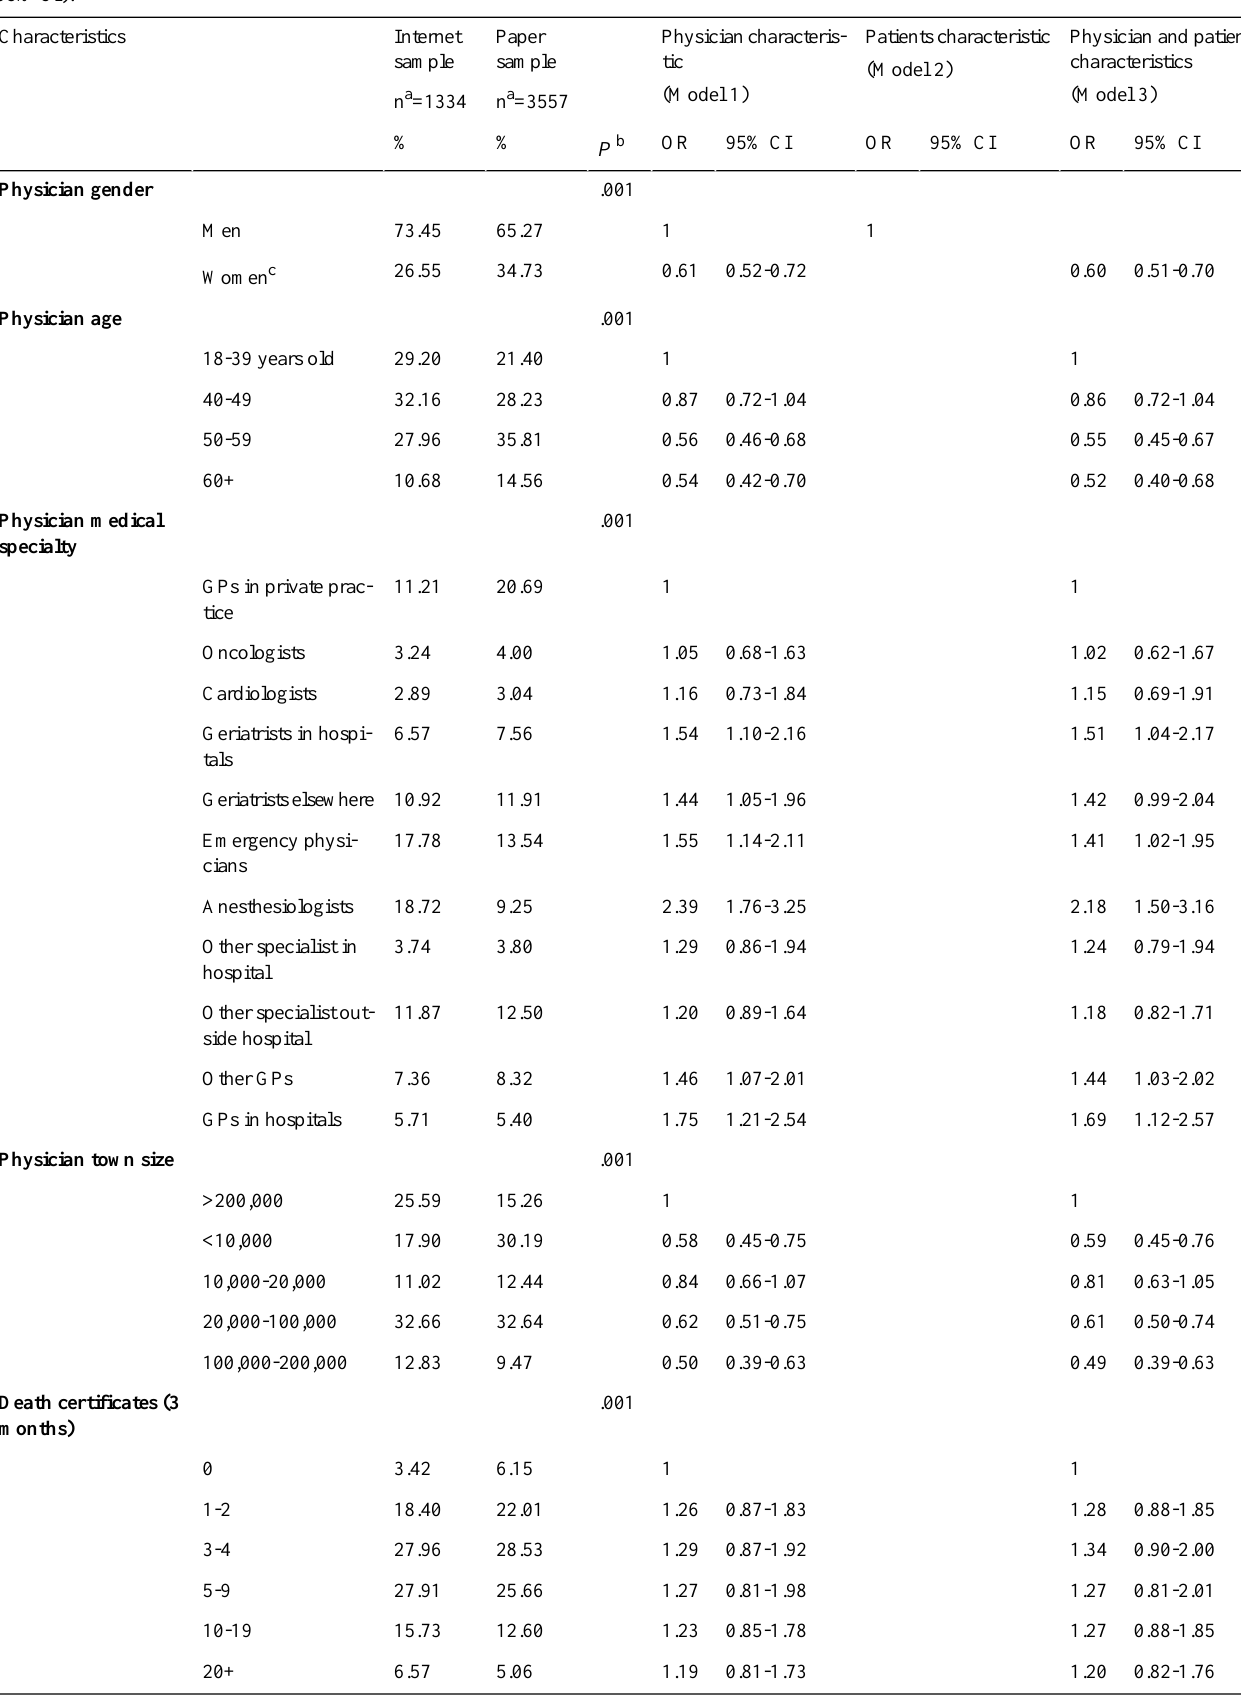
Table 5. Comparison of questionnaires completed on the Internet versus on paper: percentages, adjusted odds ratios (OR), and 95% confidence intervals (95%